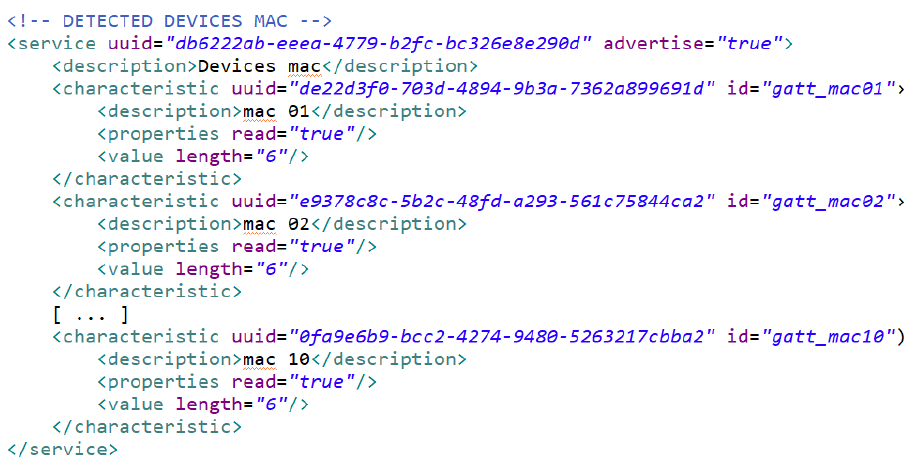
Figure 3. Sample from ten position service list storing detected BLE devices.